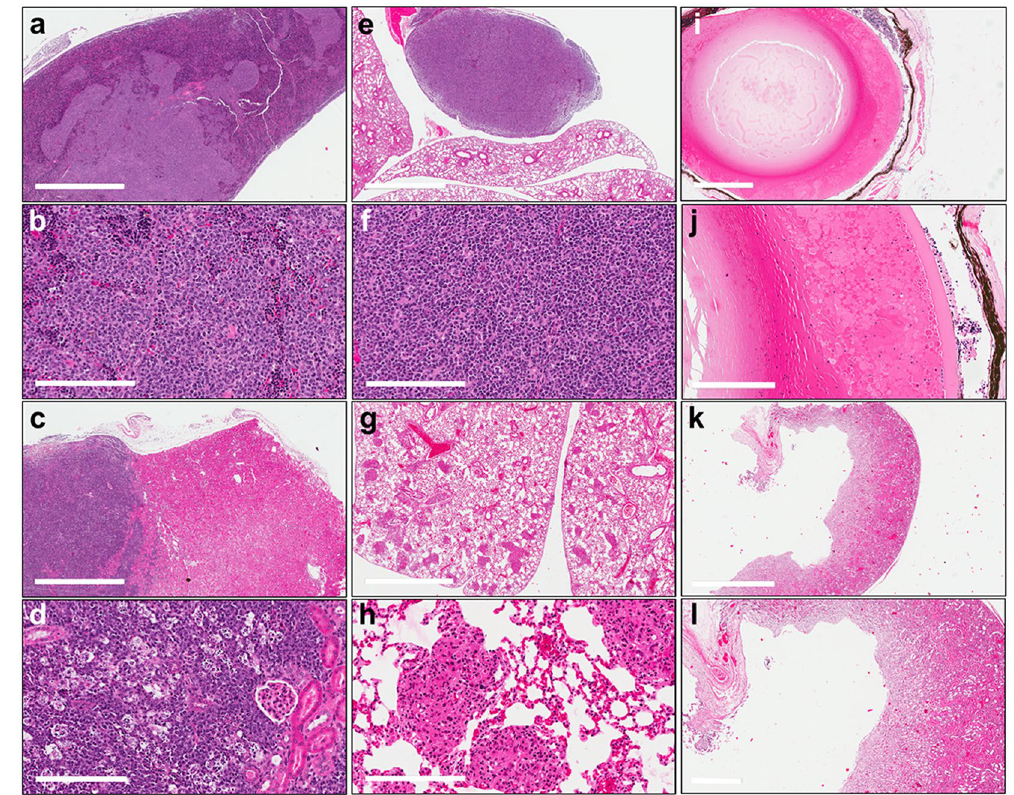
Figure 3. Histology of Kif14 transgenic mouse tumour and eye phenotypes. Low and high magnification histological H&E images of ( a,b ) follicular lymphoma in spleen; ( c,d ) diffuse large B cell lymphoma in kidney; ( e,f ) thymic lymphoma in lung; ( g,h ) sarcoma in lung; ( i,j ) ballooning degeneration of lens; and ( k,l ) hydronephrosis. Scale bars in ( a,c,e,g,k ) = 2 mm; in ( b,d,f,h,j ) = 200 µ m; in ( i,l ) = 600 µ